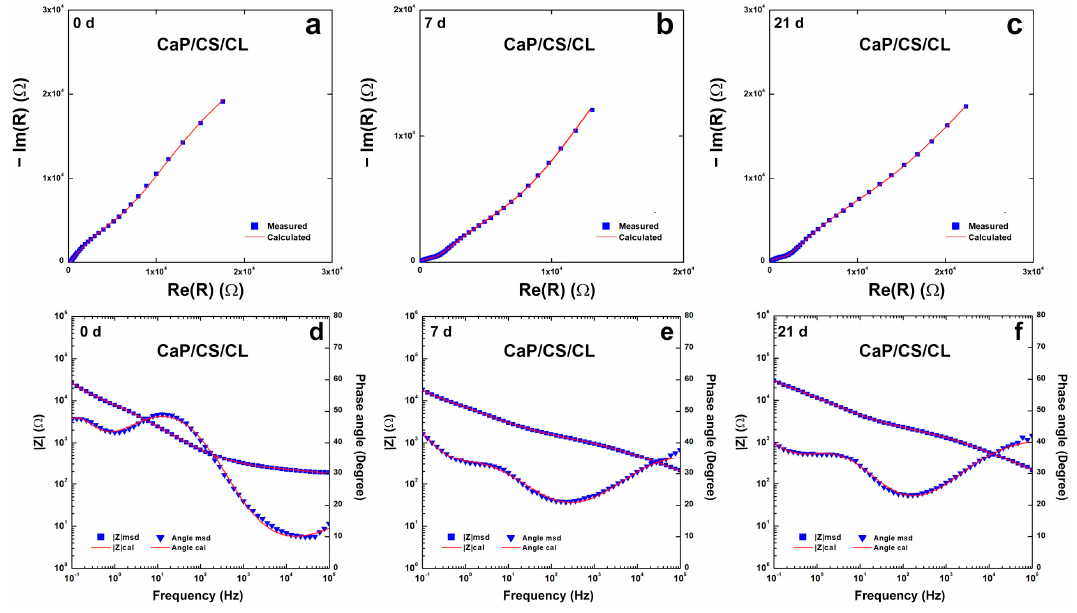
Figure 7. Impedance spectra of CaP/CS/CL coating during 3-weeks of aging in SBF solution: ( a – c ) Nyquist plots; ( d – f ) Bode plots. Impedance spectra were recorded immediately after immersion (0 D), after 1 (1 D), 7 (7 D), 14 (14 D), and 21 (21 D) days of immersion in